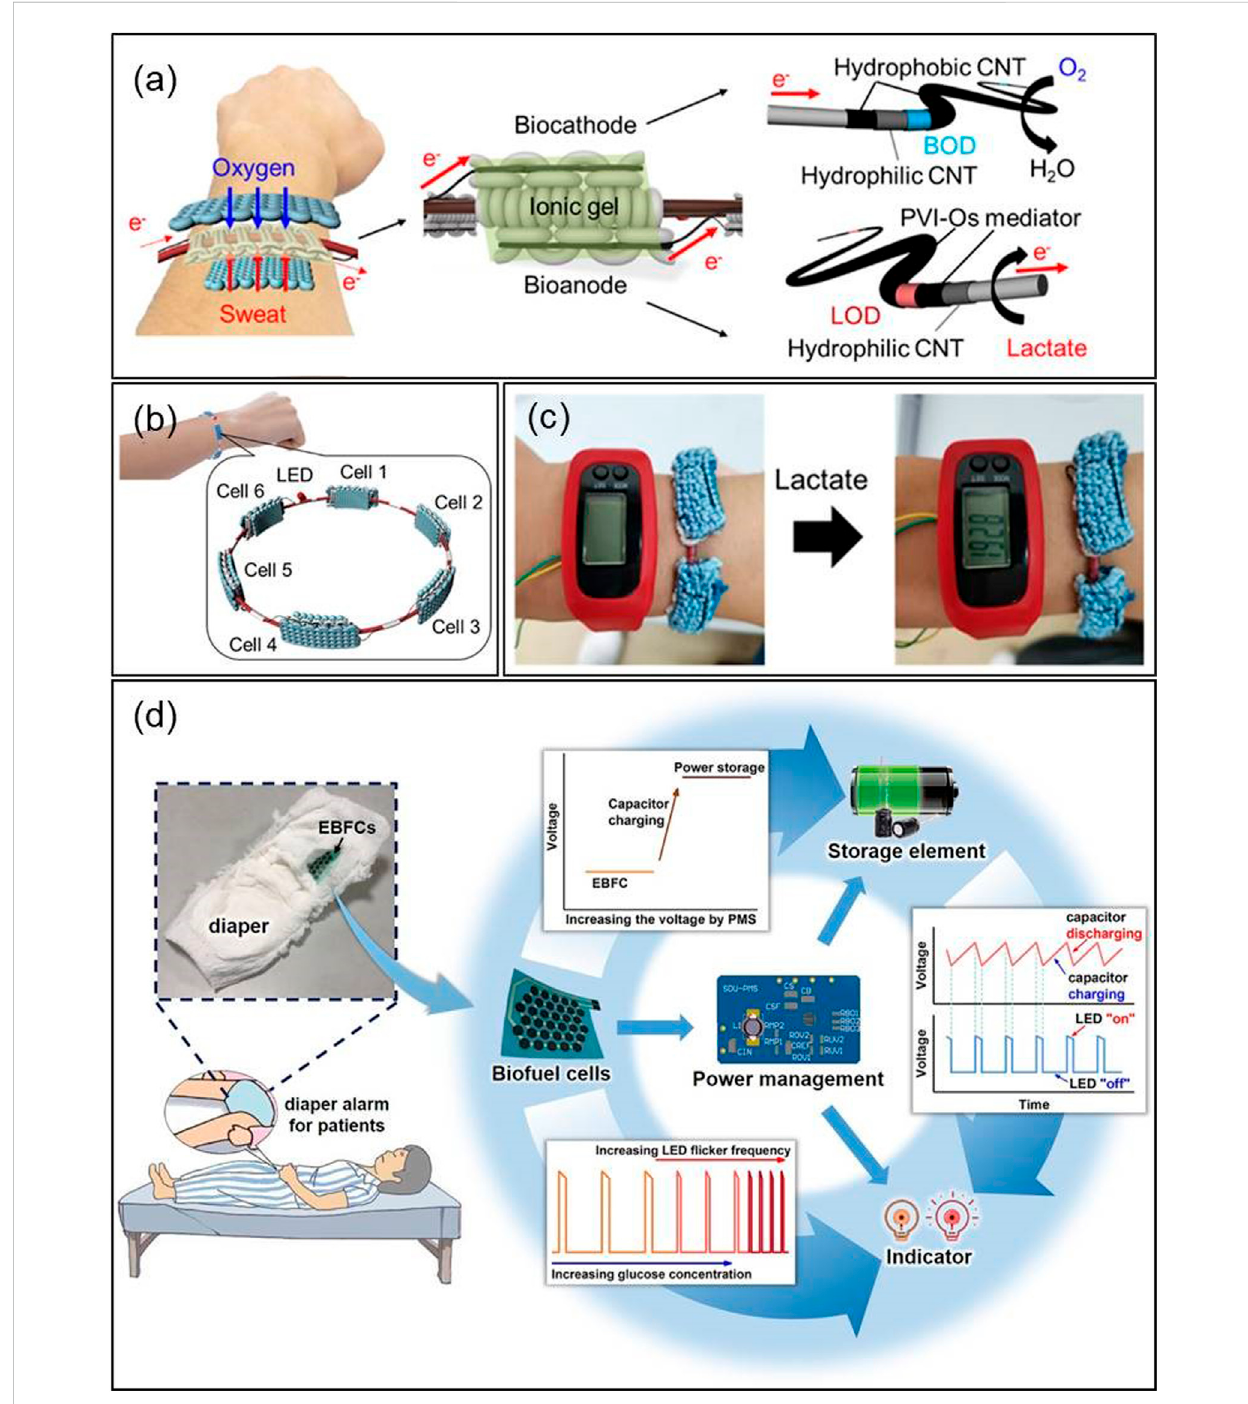
FIGURE 3 (A) Schematic diagram of the fi ber-crafted biofuel cell based on lactate biofuel from human sweat. (B) The con fi guration of the six-cell bracelet. (C) Optical photos ofpowering an electronic watchwith the bracelet-type biofuelcells (Yin et al., 2021). (D) Schematicdiagram showing thecomponents of the diaper alarm integrated with the biofuel cell-type biosensor and the circuit diagram of the alarm device (Zhang et al.,